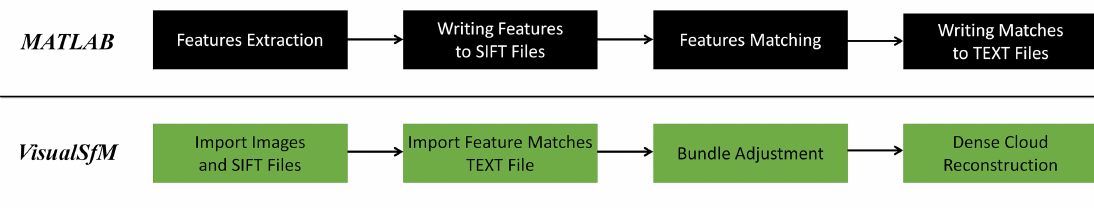
Figure 5. Workflow diagram of three-dimensional (3D) reconstruction using structure-from-motion coupled with multi-view stereo (SFM-MVS)